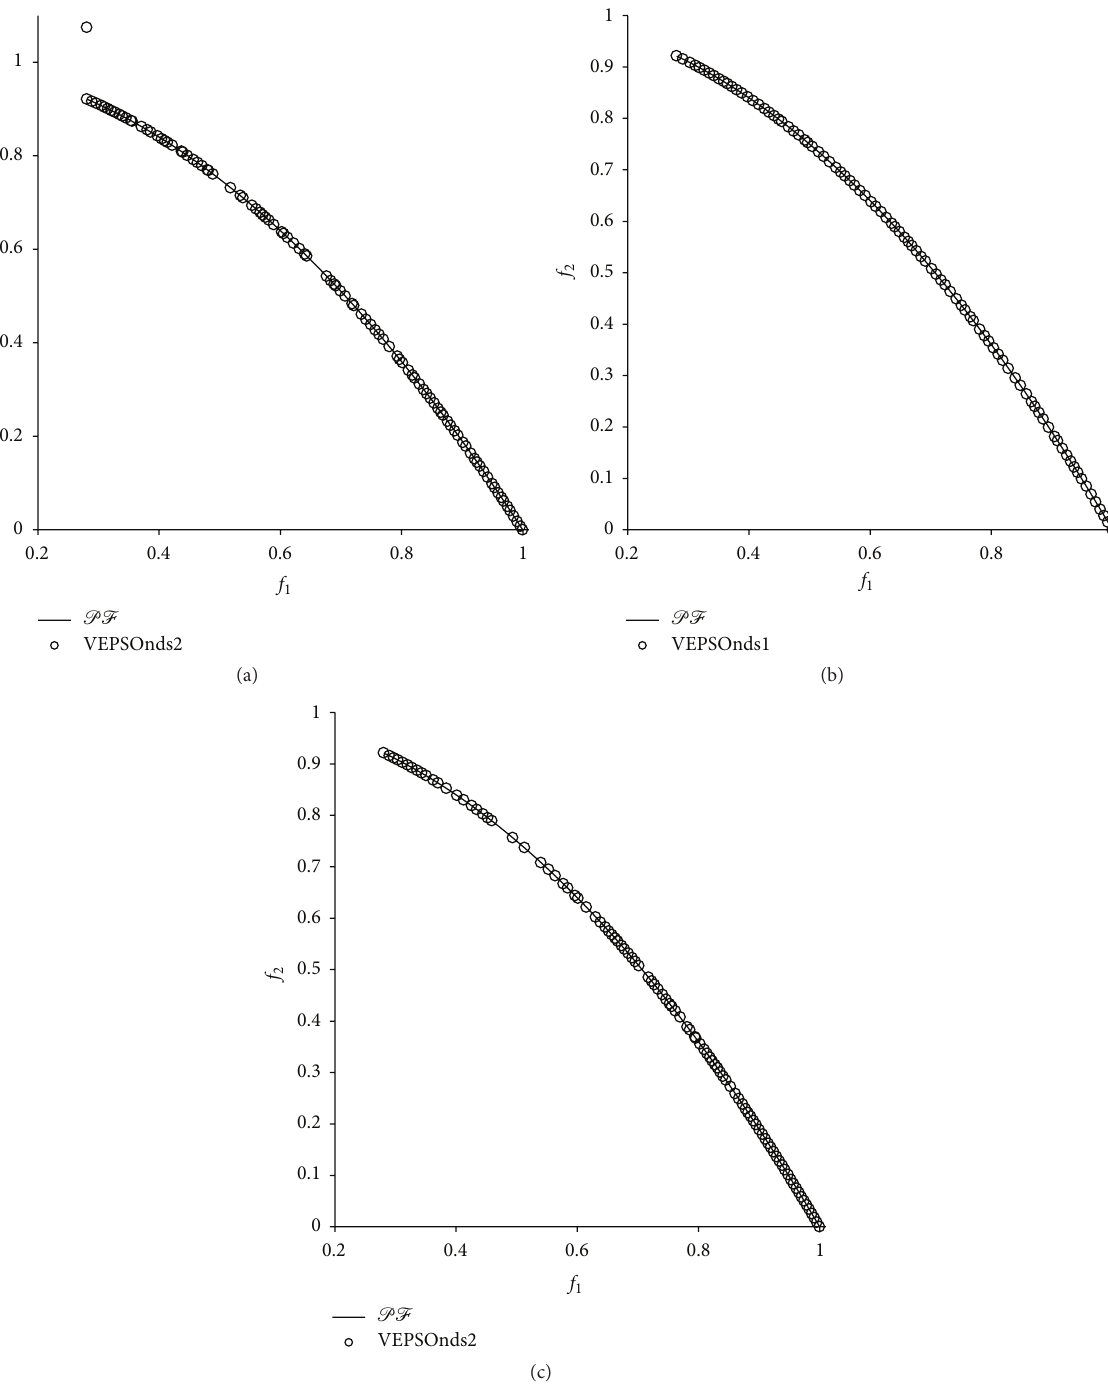
Figure 9: Plot of nondominated solutions returned by each algorithm for the ZDT6 test